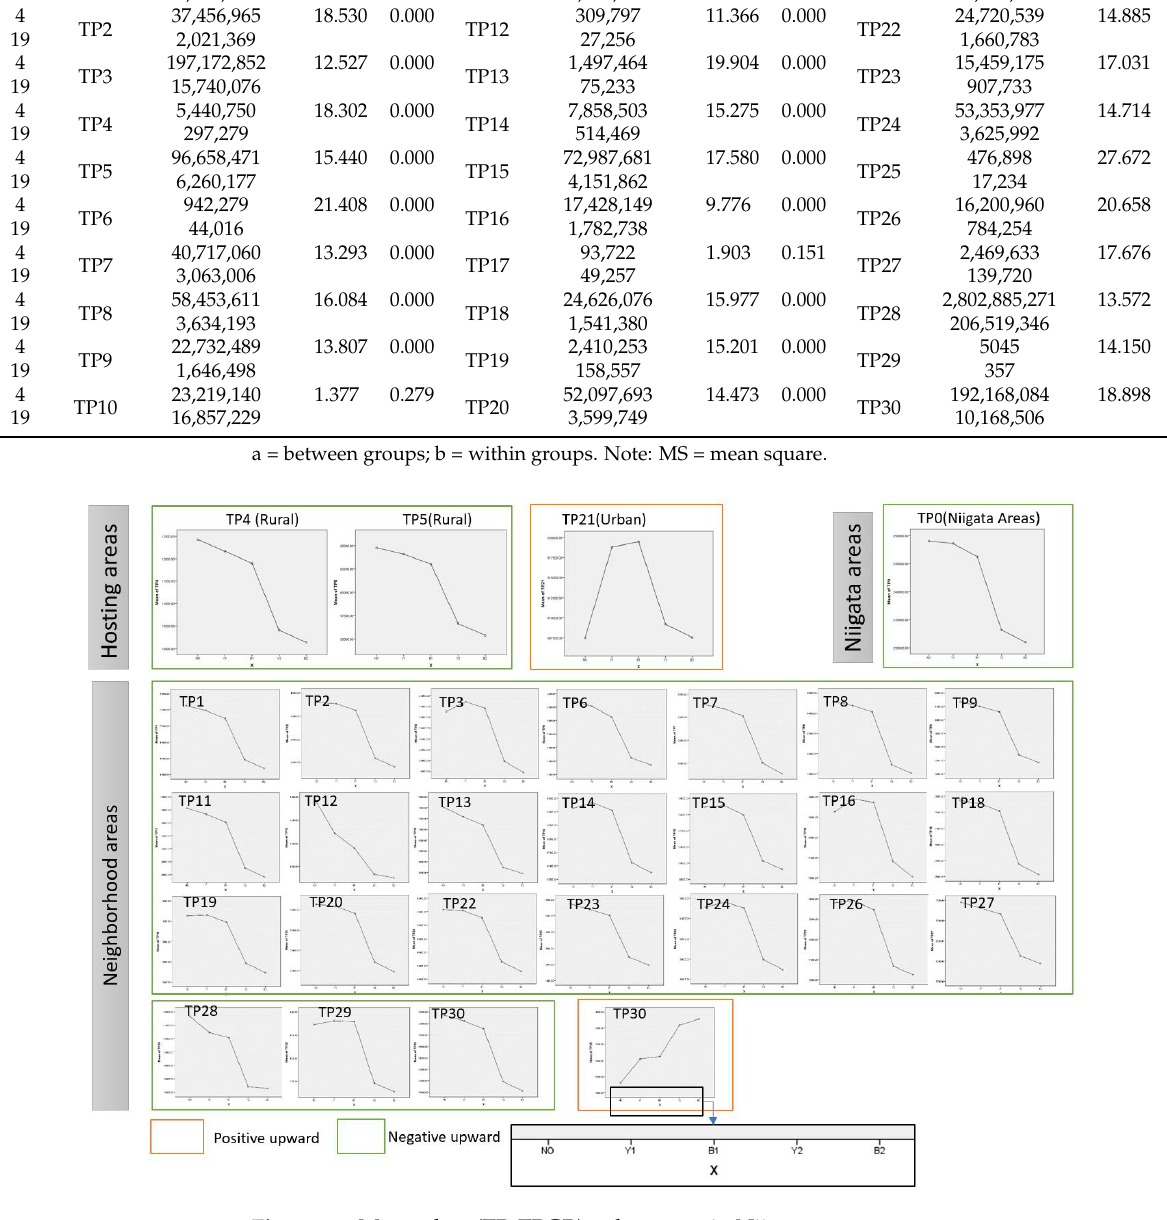
Figure 10. Mean plots (TP, TPGR): other areas in Niigata.